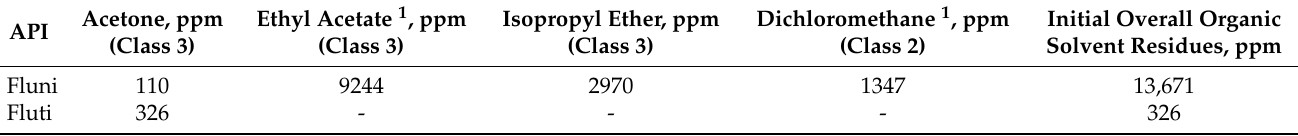
Figure 1. SEM images of ( a ) Fluni and ( b ) Fluti, as received. Table 1. Solvent residues contained in Fluni and Fluti, as